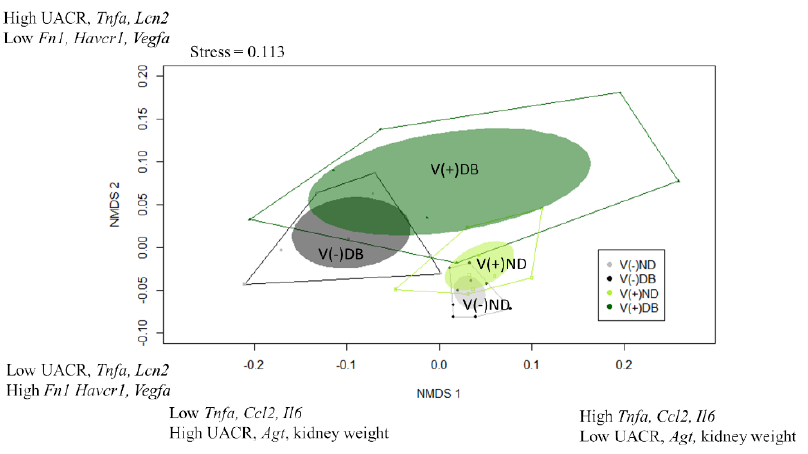
Figure 8. Non ‐ metric multidimensional scaling of kidney injury biomarkers: Gene expression data were combined with physiological data to create a dissimilarity matrix used to visualize the simi ‐ larities and differences between the four NOD mouse groups. Using two lines, the variation within the data was captured well, with a stress close to 0.1 (0.113). Plotted are NMDS1 vs. NMDS2. Solid dots represent individual animals, solid colored ellipses represent the 95% confidence interval, and open polygons represent 100% of the data. The top three drivers of group separation are noted on each axis.